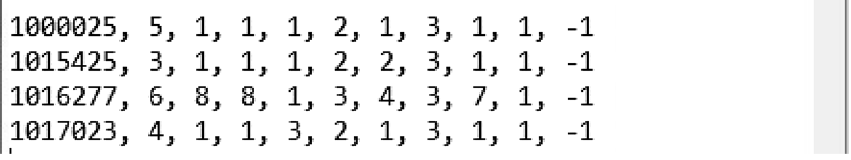
Figure 1. Snapshot of data file for breast cancer dataset WBC from 10